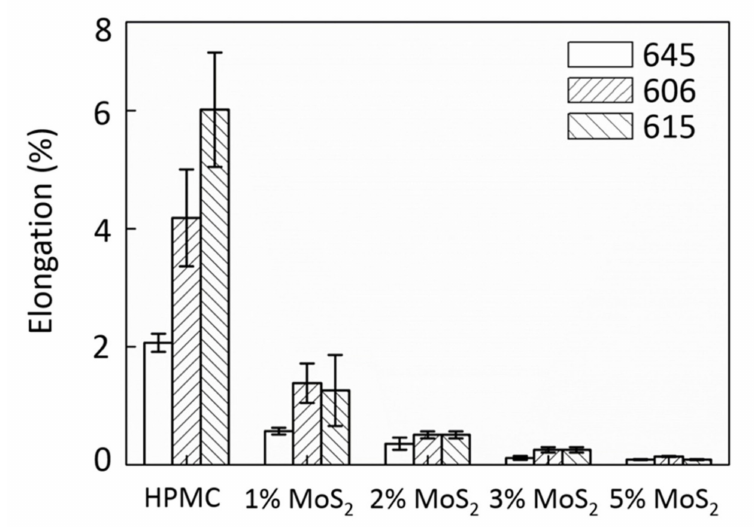
Figure 5. Elongation of MoS 2 /HPMC